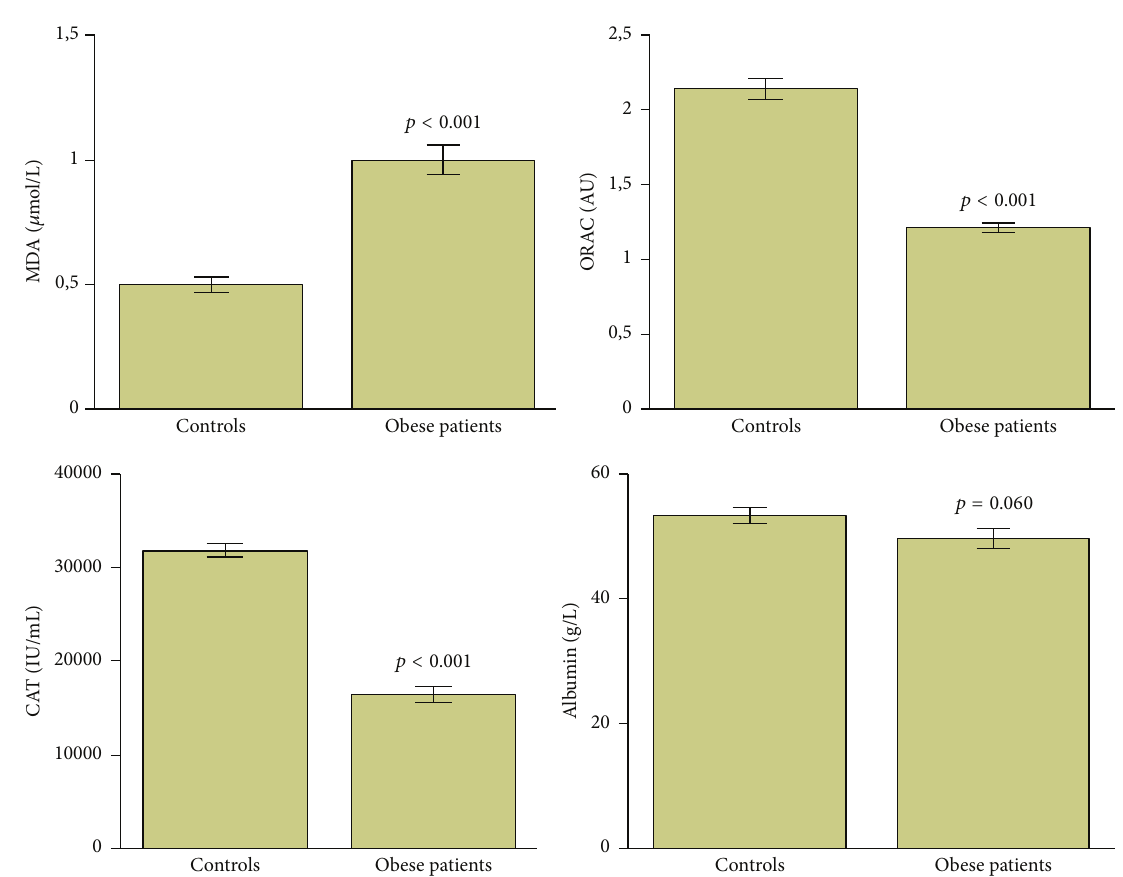
Figure 2: Oxidative stress biomarkers in obese patients and controls. 𝑝 < 0.05 was considered statistically significant. Data are presented as mean ± standard error. MDA: malondialdehyde, ORAC: oxygen radical absorbance capacity/total antioxidant capacity, and CAT: